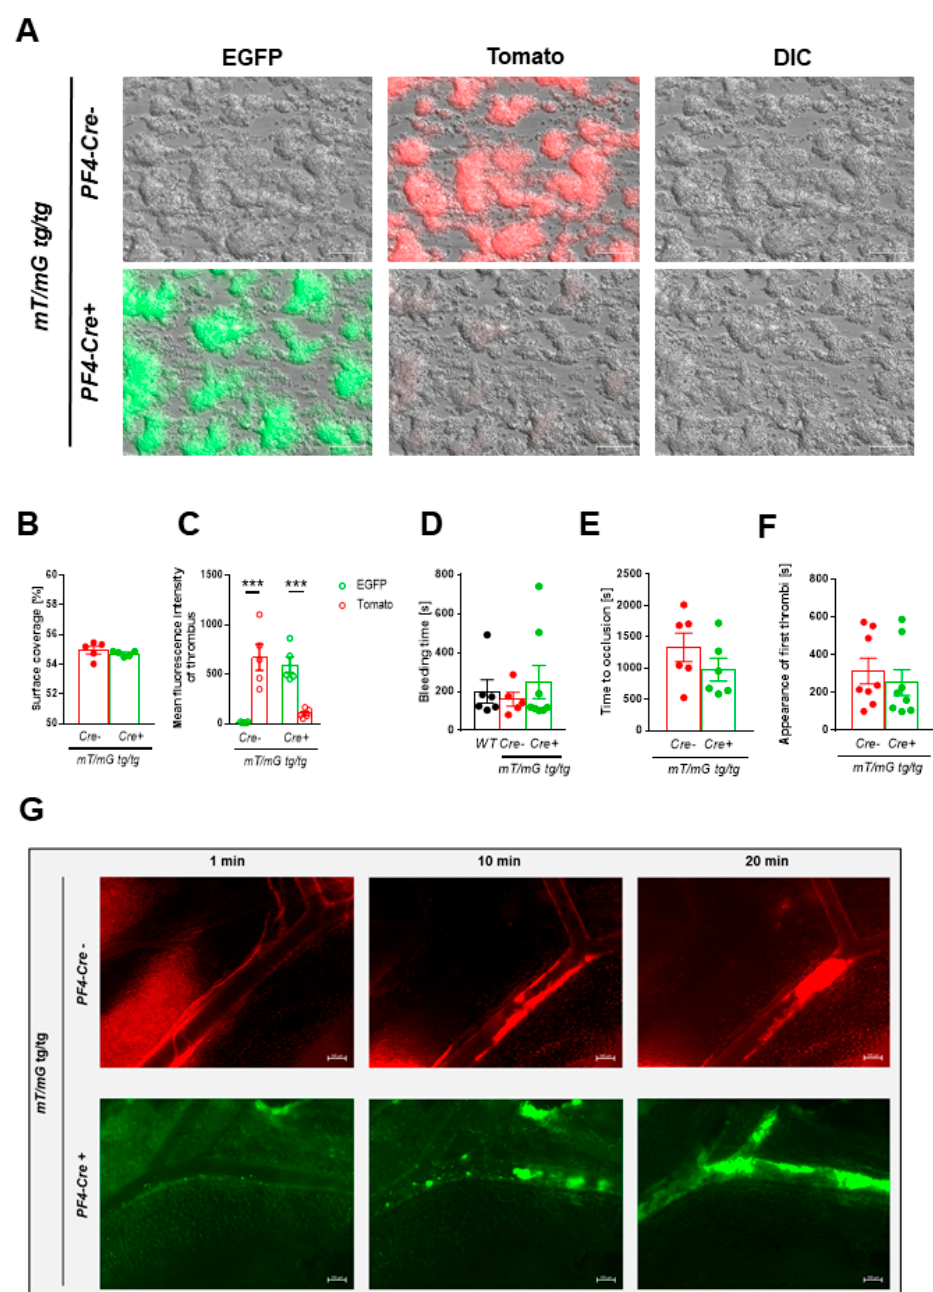
Figure 4. Unaltered thrombus formation in mT/mG;PF4-Cre negative and positive mice ex vivo and in vivo. ( A – C ) Murine whole blood was perfused over a collagen-coated matrix (200 µ g/mL) with a shear rate of 1000 s − 1 . ( A ) Representative images of thrombus formation showing mT (upper panel) or mG (lower panel) fluorescence of platelets that have been incorporated into the growing thrombus. Determination of ( B ) surface coverage and ( C ) Mean fluorescence intensity (MFI) of thrombi to quantify thrombus formation of each genotype, n = 5, scale bar 50 µ m. ( D ) Hemostasis was analyzed via tail bleeding time of mT/mG;PF4-Cre negative and positive mice. No differences between genotypes could be detected, n = 5–7. ( E – G ) In vivo thrombus formation in mesenteric arteries after FeCl 3 induced injury was analyzed using intravital microscopy. ( E ) Time to occlusion of the injured vessel and ( F ) appearance of first thrombi were determined. ( G ) Platelet aggregate formation at indicated time point was monitored by mT and mG fluorescence of platelets. mT and mG fluorescence of platelets was stable and allowed visualization of thrombus growth until full occlusion of the vessel in mT/mG;PF4-Cre mice, n = 6–8, scale bar 100 µ m. Statistical analysis was performed by two-tailed Student’s t -test ( B , C , E , F ) and Kruskal–Wallis test followed by Dunn’s post hoc test ( D ). Bar graphs depict mean values ± SEM, * p < 0.05, ** p < 0.01 and *** p <